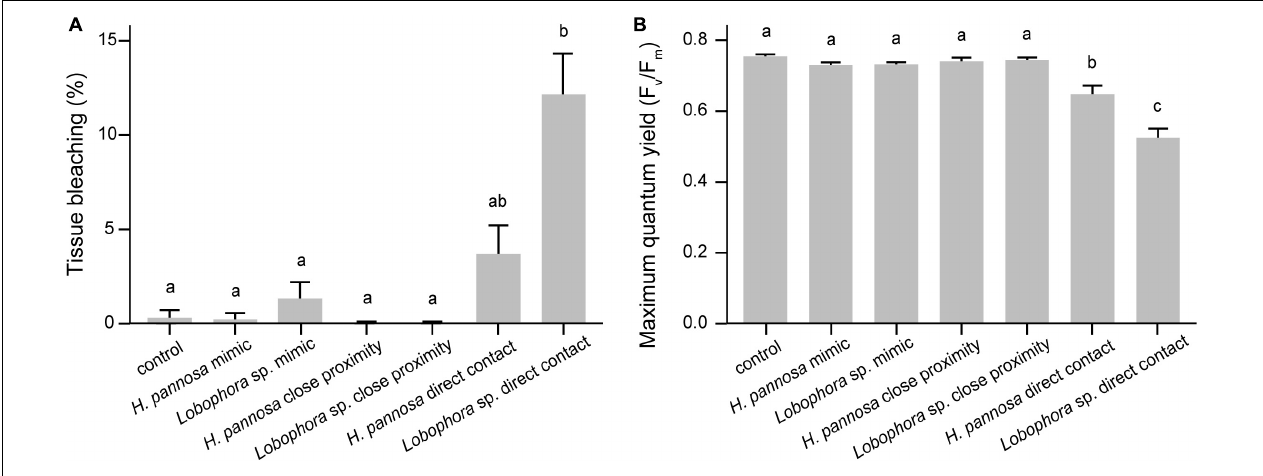
FIGURE 1 | Effects of macroalgal interactions on (A) coral tissue and (B) maximum quantum yield (F v /F m ) after 8 weeks of experiment (mean ± SE). Letters above bars indicate significant differences among treatments based on Tukey-adjusted comparisons.